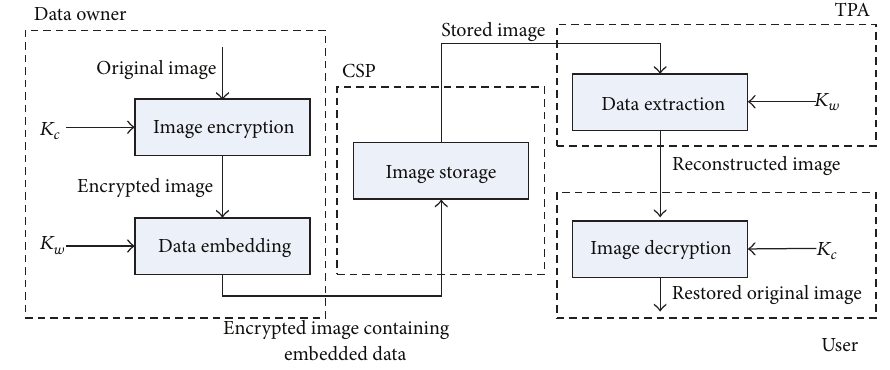
Figure 1: Sketch of the proposed